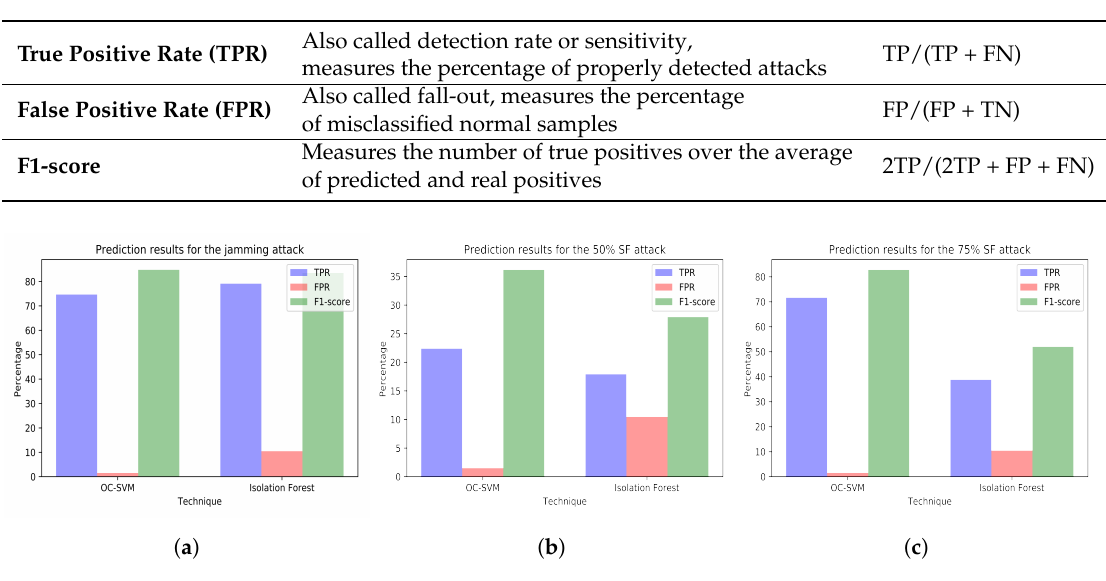
Figure 9. ( a ) prediction results for the jamming attack period using the variables from all the wireless sensor networks (WSNs) (training with dataset tr_all and test with dataset te_all_jam ); ( b ) prediction results for the 50% selective forwarding attack period using the variables from all the WSNs (training with dataset tr_all and test with dataset te_all_sf50 ); ( c ) prediction results for the 75% selective forwarding attack period using the variables from all the WSNs (training with dataset tr_all and test with dataset te_all_sf75